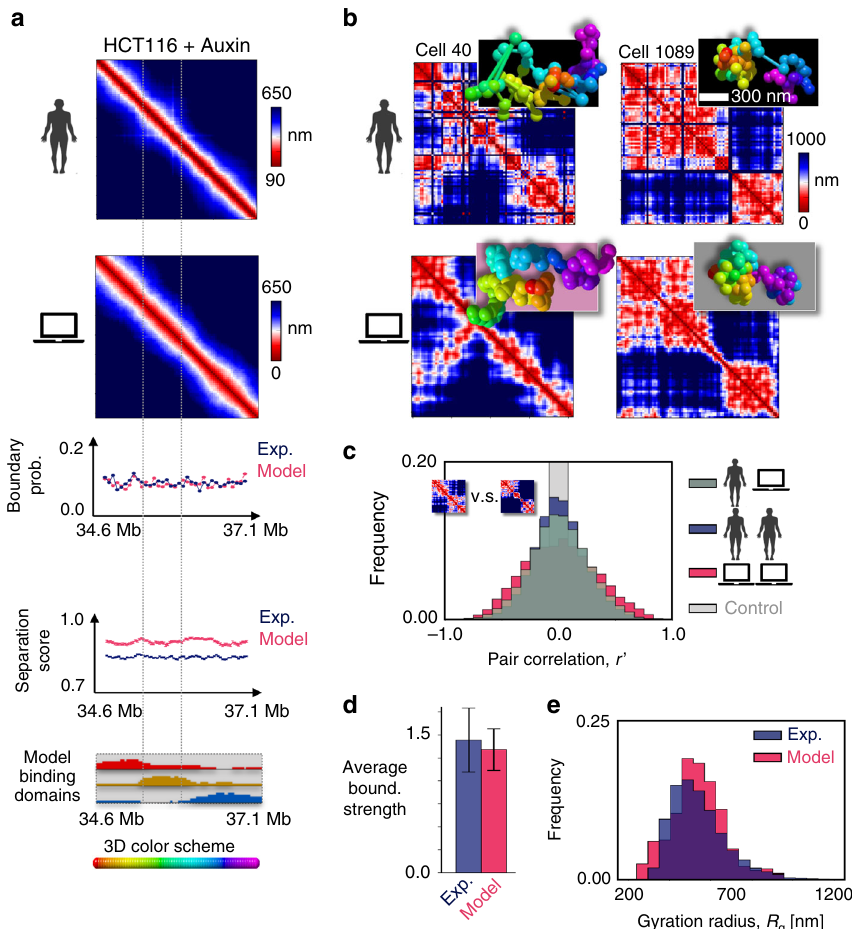
Fig. 3 Cohesin depletion tends to reverse phase separation. a Top: In cohesin depleted HCT116 cells treated with Auxin (HCT116 + Auxin), the model predicted median distance matrix of the considered locus chr21:34.6 – 37.1 Mb also compares well against independent imaging data 37 ; the Pearson and genomic-distance corrected correlations are, respectively, r = 0.96 and r ′ = 0.57. A mixture of model 3D structures is required, however, 80% in the coil and 20% in the globule state. Middle: The fl at domain boundary probability and separation score re fl ect the absence of TAD-like structures in the median matrices. Bottom: The model of the locus in cohesin depleted cells has three binding domains; their different colors are assigned by their genomic overlap with the wild-type domains of Fig. 2a. b Consistently, the RMSD based all-against-all comparison of single-cell 37 (top) and model predicted (bottom) 3D structures shows that imaged conformations correspond to model structures belonging 80% to the coil (bottom left) and 20% to the globule state (bottom right, see text and Supplementary Figs. 5c, 11). The distance matrix of single molecules has non-trivial patterns in both states, but in the coil state (bottom left) contacts originate from random collisions rather than stable phase separated globule domains (bottom right). c The distribution of genomic- distance corrected correlations between distance matrices from single-cells (blue) is broader than in wild-type and its average is r ′ = 0.0, highlighting a higher variability; it is statistically not distinguishable from the correlations between imaged and model distance matrices (dark gray, two-sided Mann – Whitney p value = 0.48). d In model and experiment the average boundary strength is similar (error bars s.d.), and similar to wild-type (Fig. 2d), and e the gyration radius distributions are not distinguishable too (two-sided Mann – Whitney p value = 0.10) and have a higher average value than wild- type (540 nm vs. 440 nm of Fig. 2e). The model-experiment agreement points out that cohesin depletion reverses phase separation in most cells as their corresponding model single-molecule structures are mainly in the coil rather than in the globule state, contrary to HCT116 (Fig.